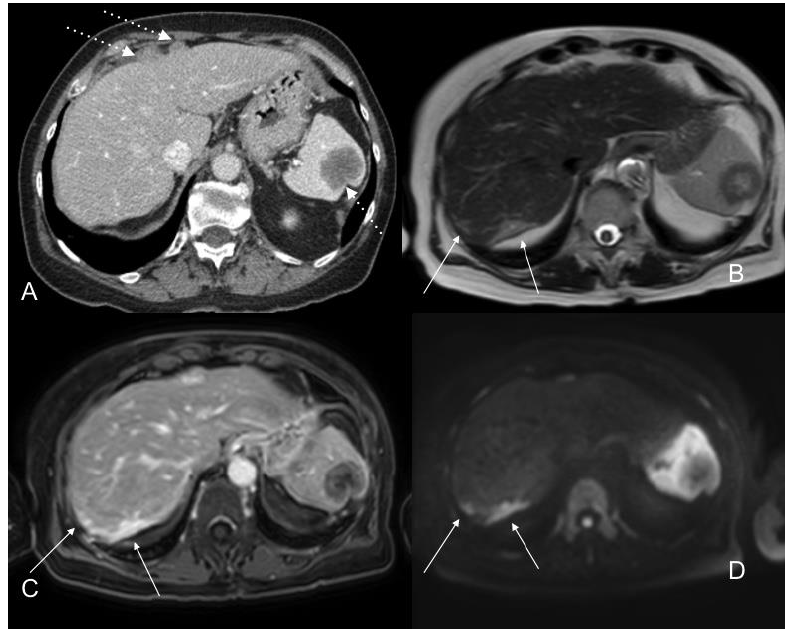
Figure 10. Portal phase contrast-enhanced CT axial images ( A ) show nodular anterior perihepatic implants as well as a splenic implant (white dotted arrows). T2WI axial ( B ), postGD DIXON axial ( C ), and DWI b800 axial ( D ) MR images also show extensive subcapsular involvement on the posterior surface of the right hepatic lobe (white arrows), not visible on CT scan. This location is a blind spot in exploratory